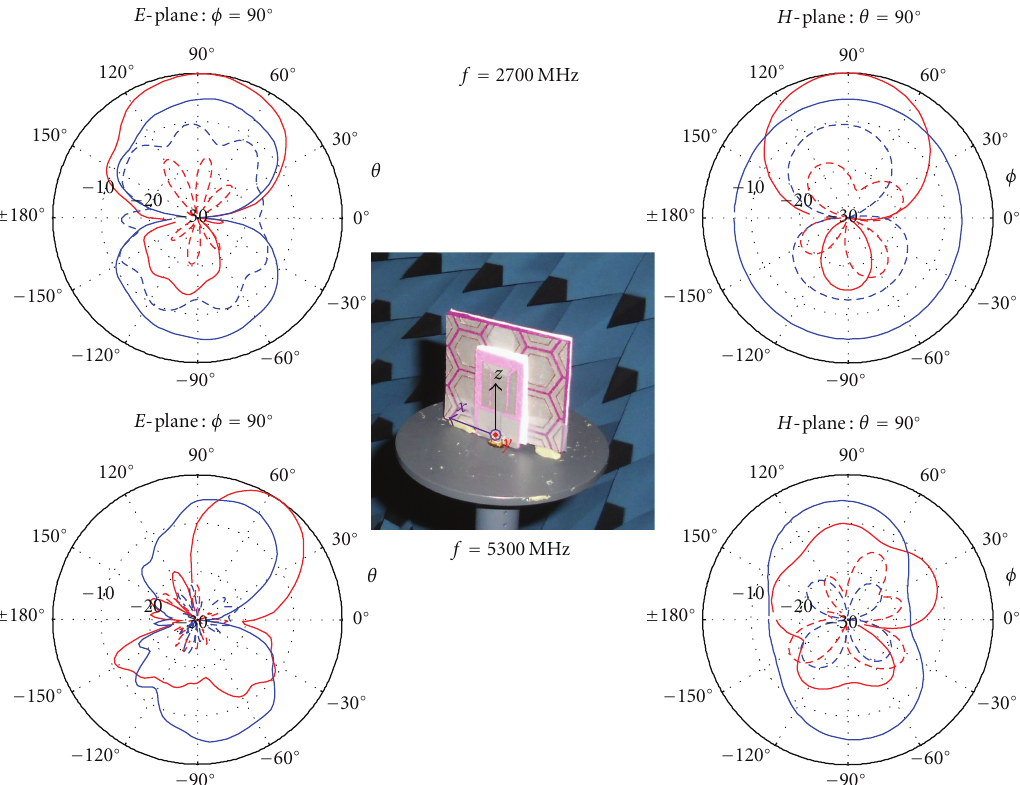
Figure 19: Measured radiation patterns (PP in solid line and XP in dashed line) at f = 2.700 GHz and f = 5.300 GHz, CP, for the CPW-fed monopole antenna without (blue) and with (red) AMC reflector, manufactured on felt substrate.